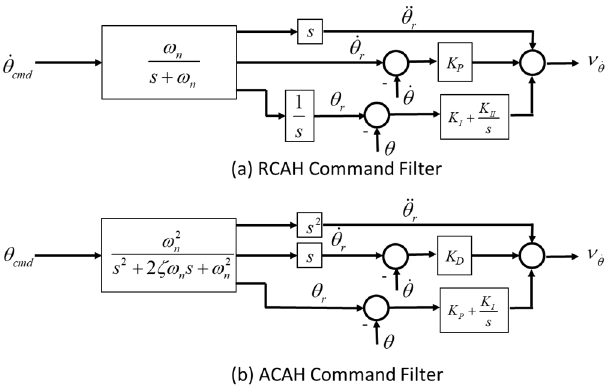
Figure 6. Structure of command filters for ( a ) rate command attitude hold, and ( b ) attitude command attitude hold.